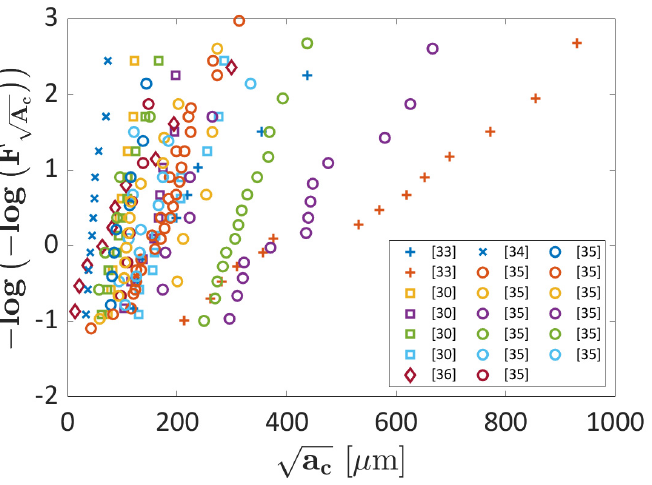
Figure 5. AlSi10Mg datasets considered for the validation of the proposed ML algorithms.